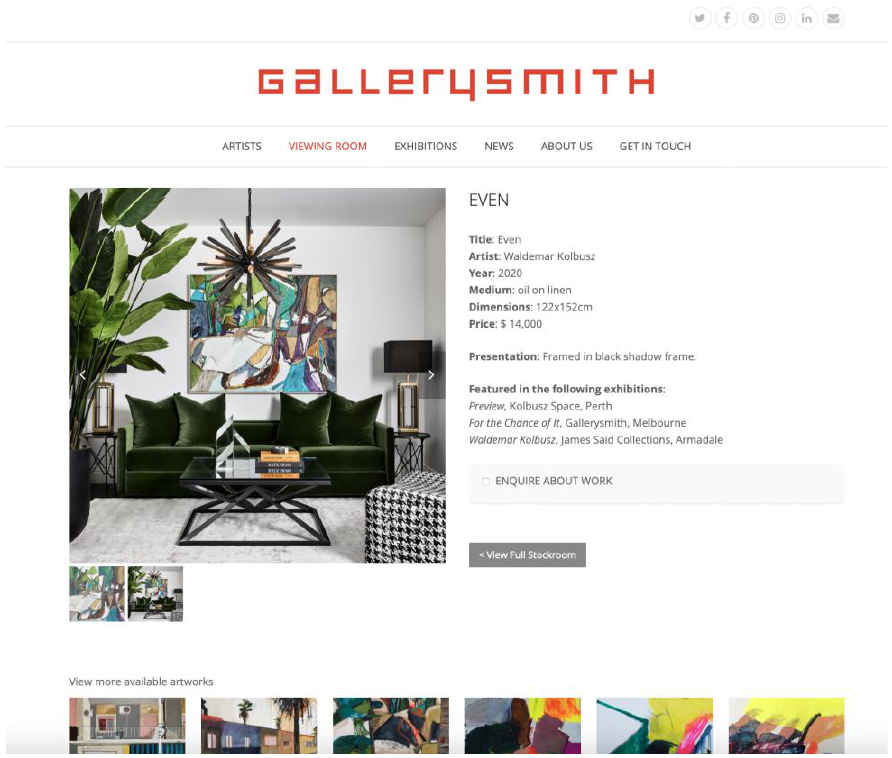
Figure 5. Gallerysmith, Melbourne. Online viewing room embedded in website. Image courtesy of Gallerysmith.